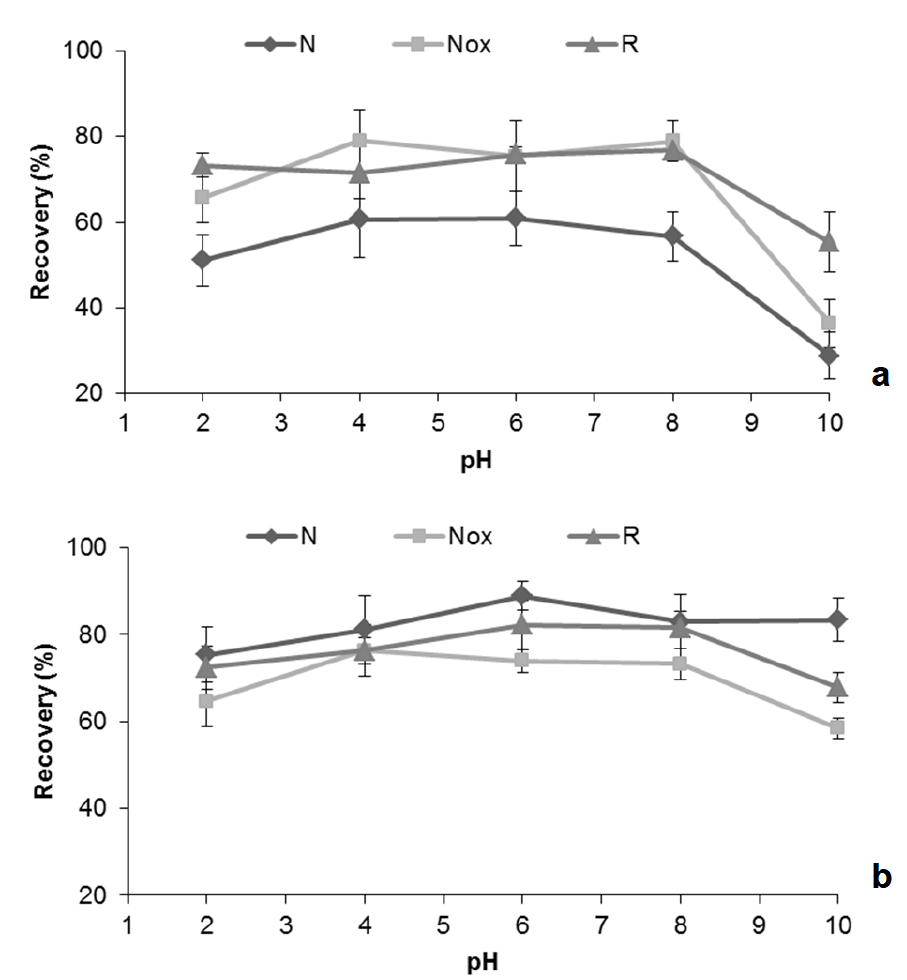
Figure 3. Effect of matrix pH on the recovery of ACF ( a ) and CAF ( b ) by MSAµE(AC) followed by liquid desorption and high-performance liquid chromatography with diode array detection (MSAµE(AC)-LD/HPLC-DAD), using different activated carbons (ACs) phases (R, N, and N OX ).